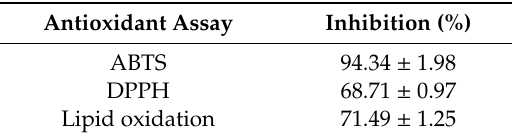
Table 6. Results of the antioxidant activities